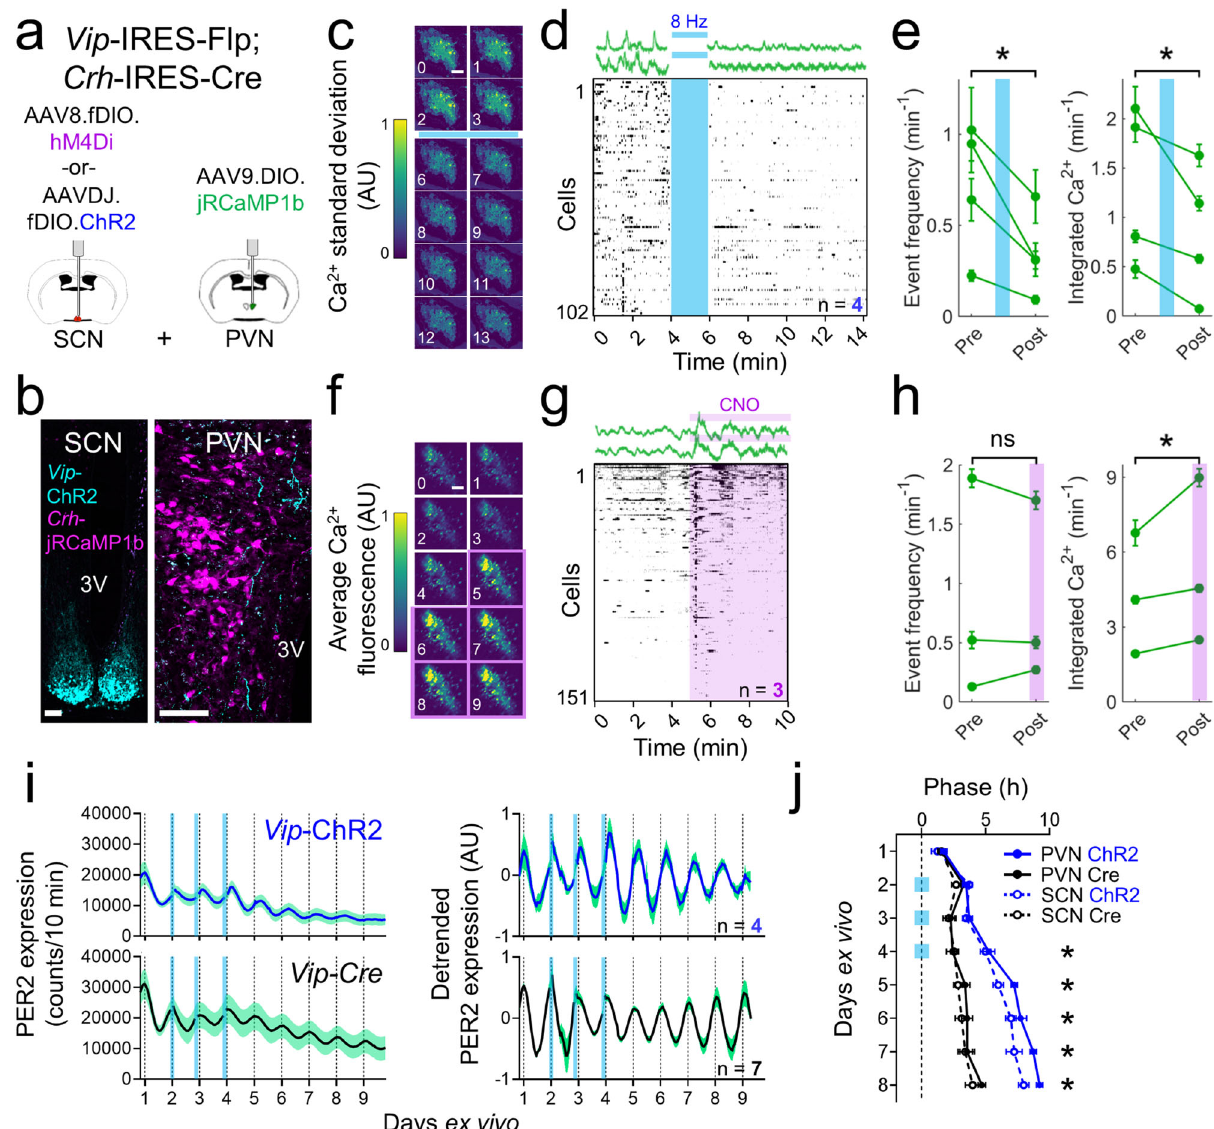
Fig. 6 SCN VIP neurons inhibit PVN CRH neuron activity and shift PVN clock gene rhythms. a Schematic for simultaneous SCN VIP neuron manipulation and PVN CRH neuron calcium imaging. b Representative ( n = 4 replicates) images from a Vip Flp/ + ; Crh Cre/ + mouse showing concurrent Flp-dependent ChR2 (cyan) and Cre-dependent jRCaMP1b (magenta) expression. 3V third ventricle. Scale bar = 100 µ m. c The change in calcium fl uorescence over each minute of recording in an individual ex vivo PVN slice before and after stimulation (blue bar; 470 nm, 8 Hz, 10 ms pulse width, 2 min duration) around subjective dusk (circadian time (CT) 11-12). Warmer colors represent a greater change in calcium fl uorescence. d Top, representative calcium traces (in Δ F / F ) from two PVN CRH neurons recorded before and after stimulation. Bottom, raster plot depicting PVN CRH neuron calcium activity in individual neurons before and after SCN VIP stimulation ( n = 102 cells, 4 slices). Raster plot was thresholded to show the upper 50% Δ F / F of each trace for visualization. e Calcium event frequency and integrated calcium levels in PVN CRH neurons in each PVN slice (green lines, mean ± SEM) before and after SCN VIP stimulation (blue line). Two-way repeated-measures ANOVA, p < 0.001 for event frequency and integrated calcium levels. f The average calcium fl uorescence over each minute of recording in an individual ex vivo PVN slice before and during clozapine-N-oxide (CNO) treatment (purple shading, 1 µ l of 10 µ M CNO) around subjective afternoon (CT 6-8). Warmer colors represent increased calcium fl uorescence. g Top, representative calcium traces from two PVN CRH neurons recorded before and during CNO treatment. Bottom, raster plot depicting PVN CRH neuron calcium activity in individual neurons before and after CNO treatment ( n = 151 cells, 3 slices). h Calcium event frequency and integrated calcium levels in PVN CRH neurons in each PVN slice (green lines, mean ± SEM) before and during SCN VIP inhibition (purple shading). Two-way repeated-measures ANOVA, p < 0.001 for integrated calcium levels, p = 0.345 for event frequency. i (Left) Raw and (right) detrended PER2::LUC bioluminescence traces from the PVN of Vip Cre/ + ; PER2 LUC/ + (black, n = 6) and Vip Cre/ + ; Ai32 fl / + ; PER2 LUC/ + (blue, n = 4) mice stimulated for 1 h per day for 3 d (blue bars, 8 Hz, 470 nm, 10 ms). j Peak times of PER2::LUC bioluminescence in PVN (solid circles and lines) and SCN (open circles, dashed lines) slices from Vip -ChR2 (blue) and Vip -Cre (black) mice before, during, and after daily optogenetic stimulation (blue squares). Peak times between ChR2 and control PVN were signi fi cantly different on days 4 – 8 (Two-way circular ANOVA, p < 0.001 on each day). Source data are provided as a Source Data fi